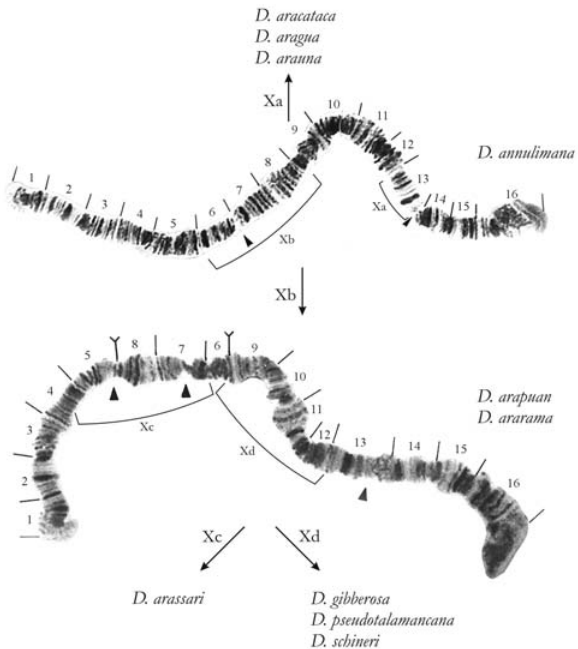
Figure 5 - Relationships among ten Drosophila species of the annulimana group based on the inversions observed in the X chromosome. D. annulimana, D. aracataca and D. aragua have the X-5 fusion. The break- points of inversions Xa, Xb, Xc and Xd are indicated.